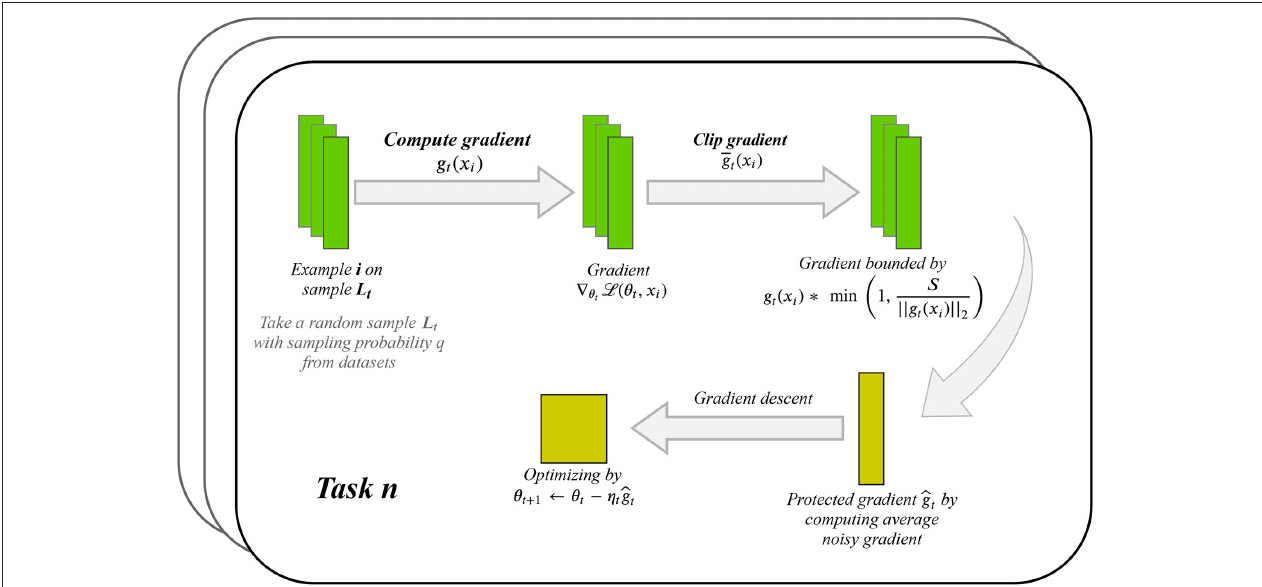
FIGURE 1 | Per iterative computation process for preserving privacy on each learning task.